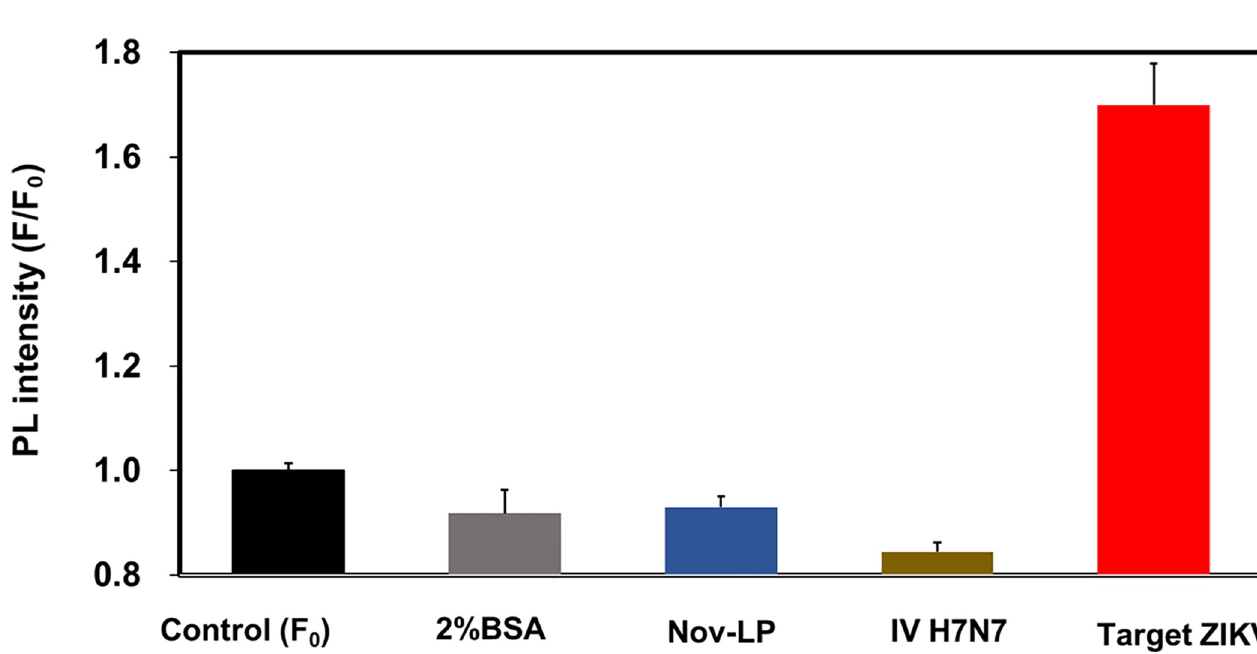
Fig 7. Specificity of our proposed detection method. Fluorescence intensity of ZIKV was compared with those of NoV-LPs, influenza virus A (H7N7) BSA, and BSA as negative control. The concentration of the sample used was 100 ng/mL for NoV-LPs and influenza virus A (H7N7) and 1 × 10 5 RNA copies/mL for the